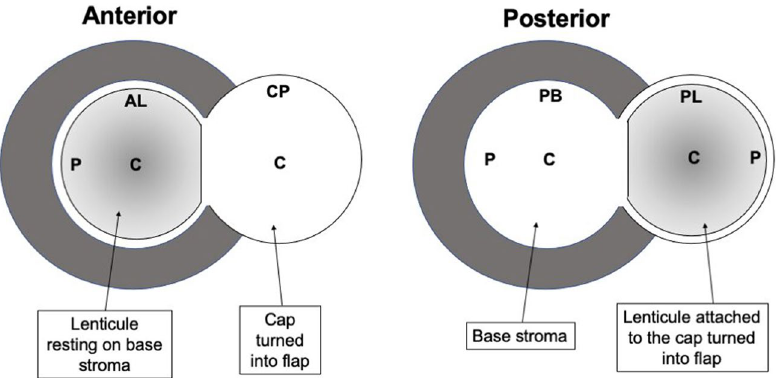
Figure 2. Figure showing areas of scanning when the lenticule was attached to the stromal bed or the cap after the cap was dissected to be lifted like a flap. AL-P = anterior lenticule surface periphery; AL-C = anterior lenticule surface centre; CP-C = Centre of cap’s posterior surface; PL-P = posterior lenticule surface periphery; PB-P = posterior stroma base periphery; PL-C = posterior lenticule surface centre; PB-C = posterior stroma base